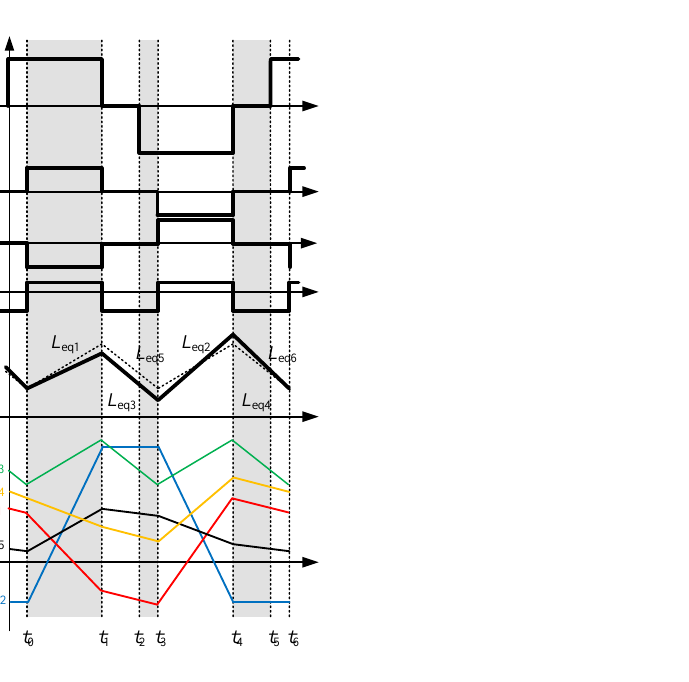
Figure 5. Six switching modes of the phase-shifted full-bridge converter: ( a ) Mode 1, ( b ) Mode 2, ( c ) Mode 3, ( d ) Mode 4, ( e ) Mode 5 and ( f ) Mode 6.